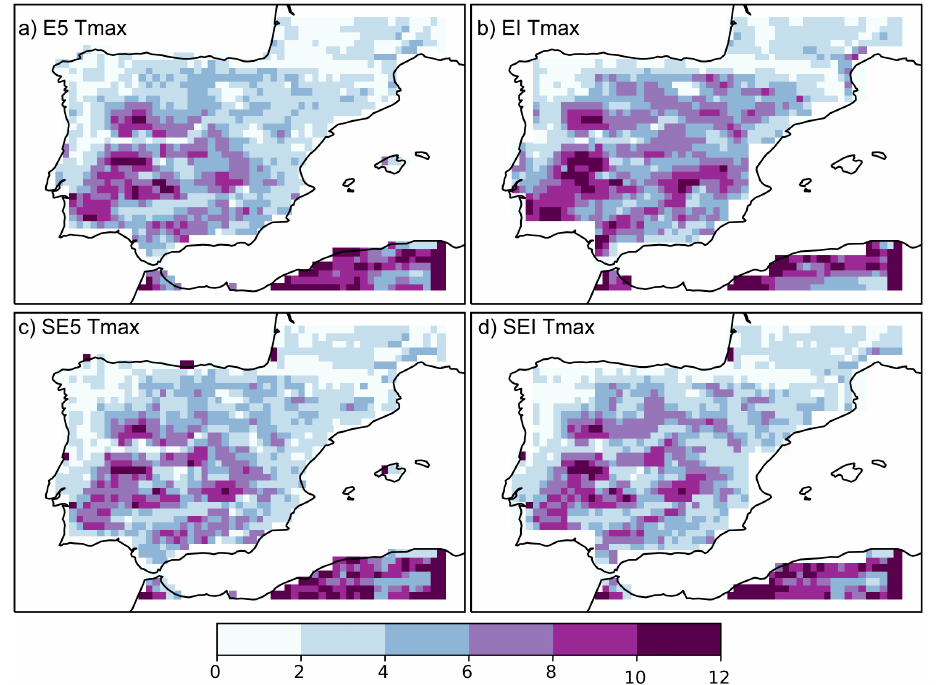
Figure 4. Tmax Root Mean Square Error (K) in: ERA5 ( a ), ERA-Interim ( b ) and the simulations forced with ERA5 ( c ) and ERA-Interim ( d ).